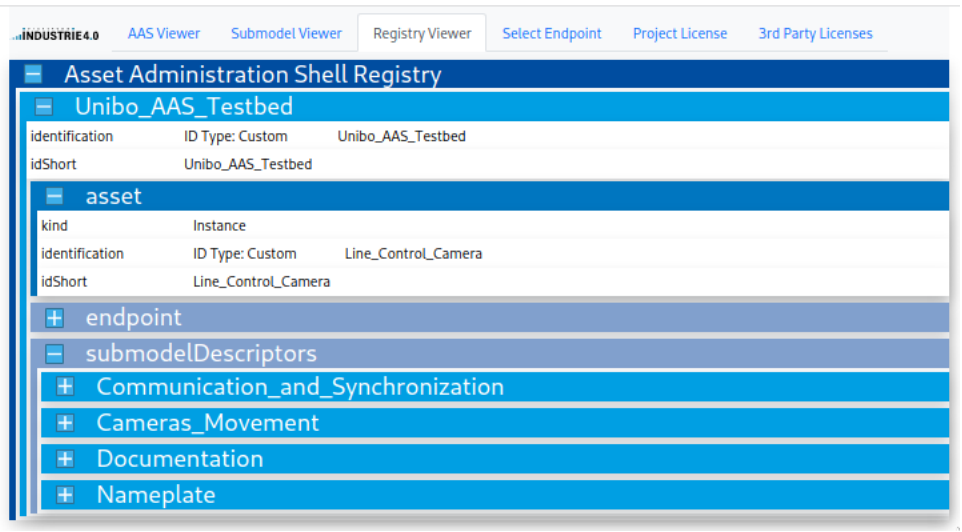
Figure 3. Screenshot of the Asset Administration Shell